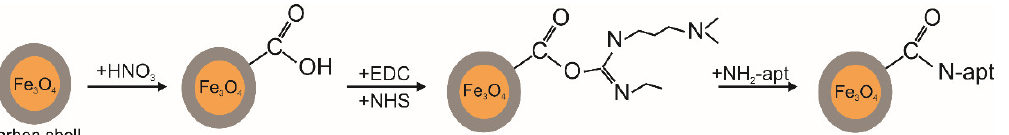
Figure 2. The scheme of the functionalization of carbon shell by aptamers. EDS and NHS—buffer solution with Ca 2+ and Mg 2+ , pH = 7.4, containing: 1-ethyl-3-(3-dimethylaminopropyl) carbodiimide